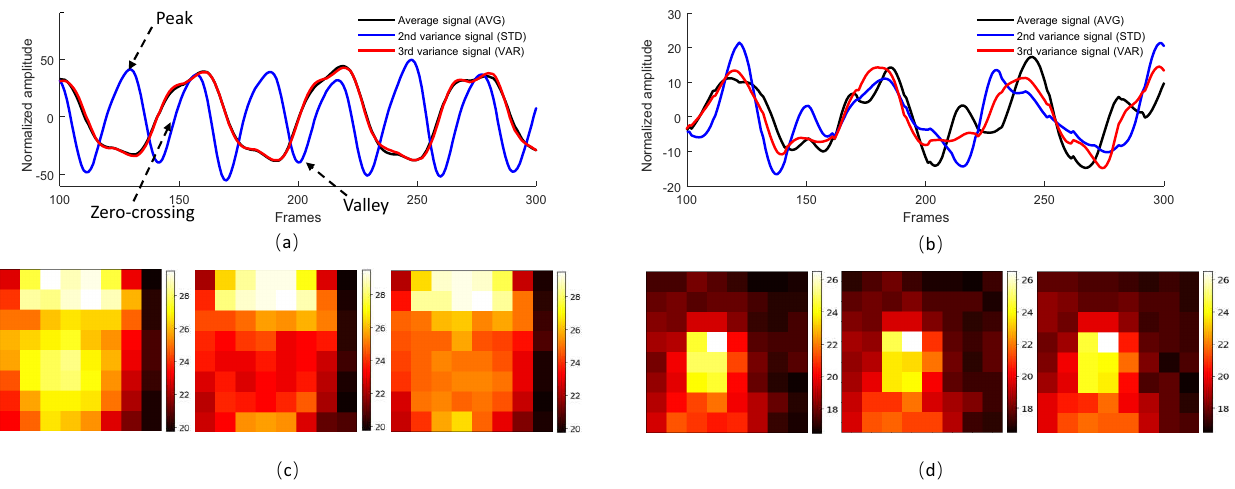
Figure 5. The spatially averaged, 2nd-order variation signal (standard deviation) and 3rd-order variation signal extracted from the thermopile video where the subject wears a face mask and the distance between the subject and sensor is ( a ) 10cm and ( b ) 50cm, respectively. The left column, middle column and right column of thermal images ( c ) are taken at the peak (exhaling), valley (inhaling) and zero-crossing of the respiratory signal ( a ). The left column, middle column and right column of thermal images ( d ) are taken at the peak (exhaling), valley (inhaling) and zero-crossing of the respiratory signal ( b